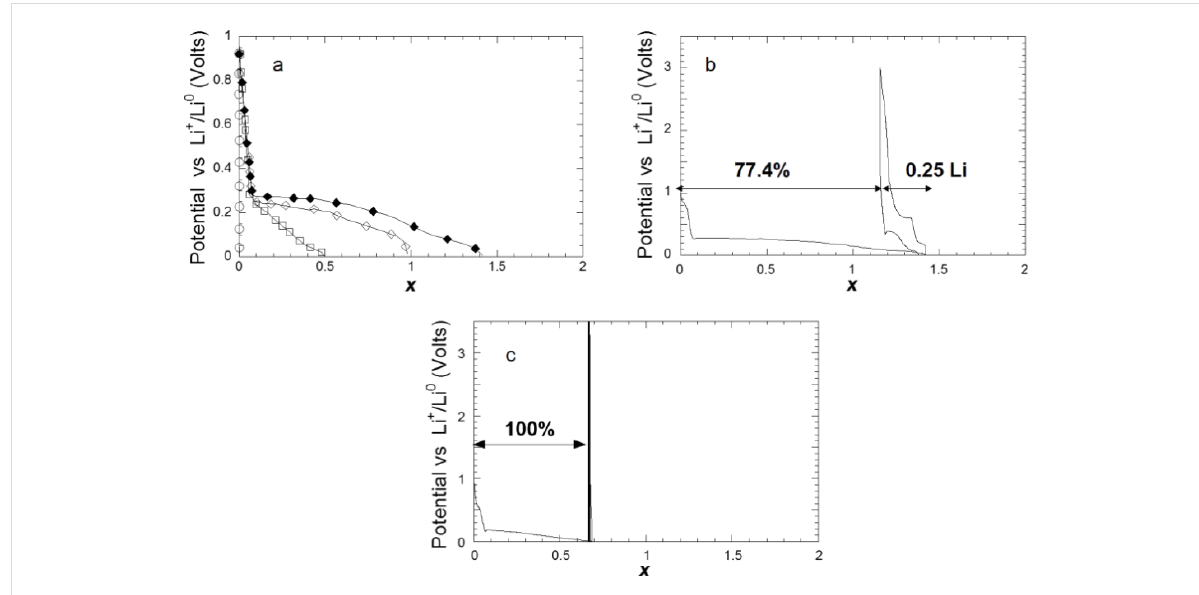
Figure 10: The evolution of the potential (V) as a function of x (mole fraction of Li) for a MgH 2 electrode prepared with commercial hydride cycled between 3 and 0.005 V. a) Discharge curves at a rate of one equivalent of lithium in 100 h as function of the content of Super p carbon of the elec- trode: open circles: 0%, open squares: 15%, open diamonds: 20%, black diamonds: 25%. b) Discharge–charge curve at a rate of one equivalent of lithium in 100 h for a content of 25% of Super P carbon. c) Discharge–charge curve at a rate of one lithium in 10 h for a content of 25% of Super P carbon at a rate of one lithium in 10 h